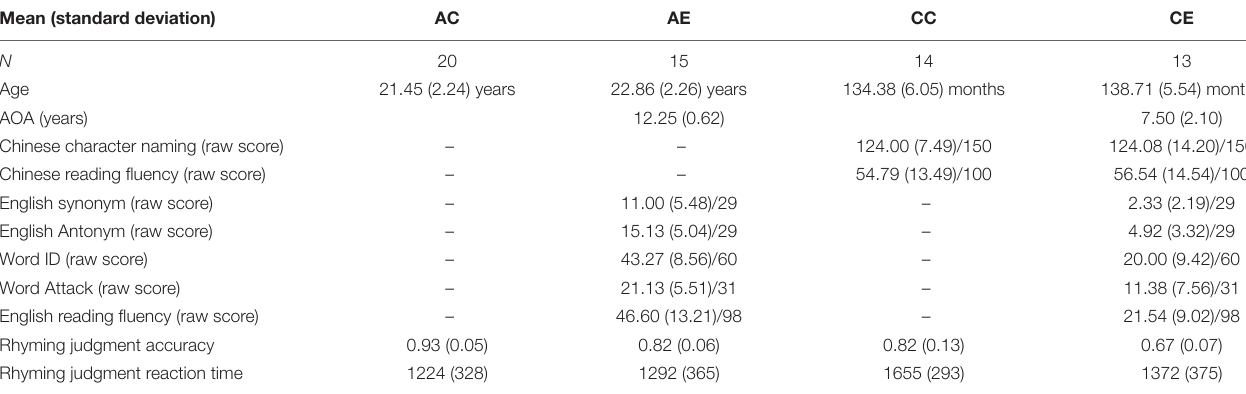
TABLE 1 | Demographic information and testing scores for the four groups of